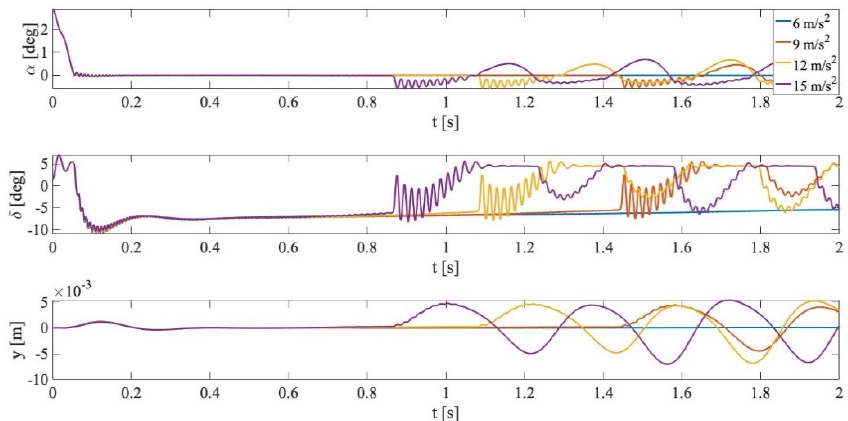
Figure 18. Controller stress case.